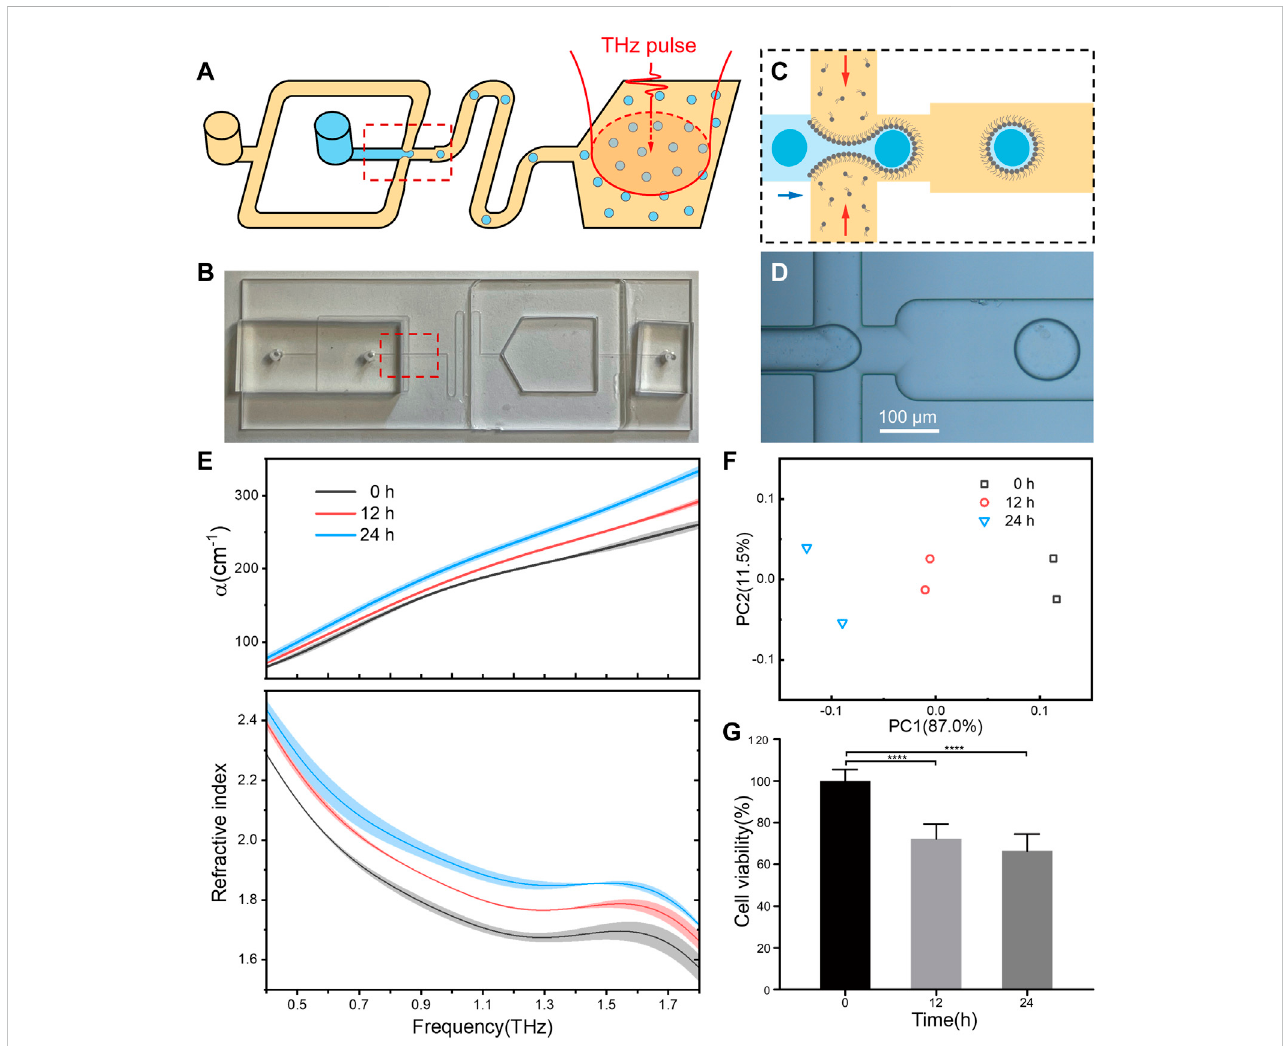
FIGURE 4 The integrating of droplet micro fl uidics for automated and high-through performance. (A) Schematic of the micro fl uidic device that can generate droplet sample and perform THz-TDS detection. An aqueous phase containing cells was passed through a fl ow-focusing junction where it met an oil phase containing lipids, leading to the generation of droplets. Red arrows show the position of a cell before and after encapsulation. Droplets were collected in a quartz chamber which severed as the terahertz measurement cuvette. (B) The optical image of the micro fl uidic chip. (C,D) The schematic and optical image of the droplet generation process. (E) Refractive index spectra of the droplets containing HepG2 cells after treatment by resveratrol for 0, 12 and 24 h. All groups were set to the same cell concentration of 1.4 × 10 5 cells/well. For each group of cells, the droplets were prepared and measured twice, and the shaded area indicates the error bars. (F) Principal component analysis (PCA) plots of the measured refractive index. (G) Cell viability of resveratrol treated HepG2